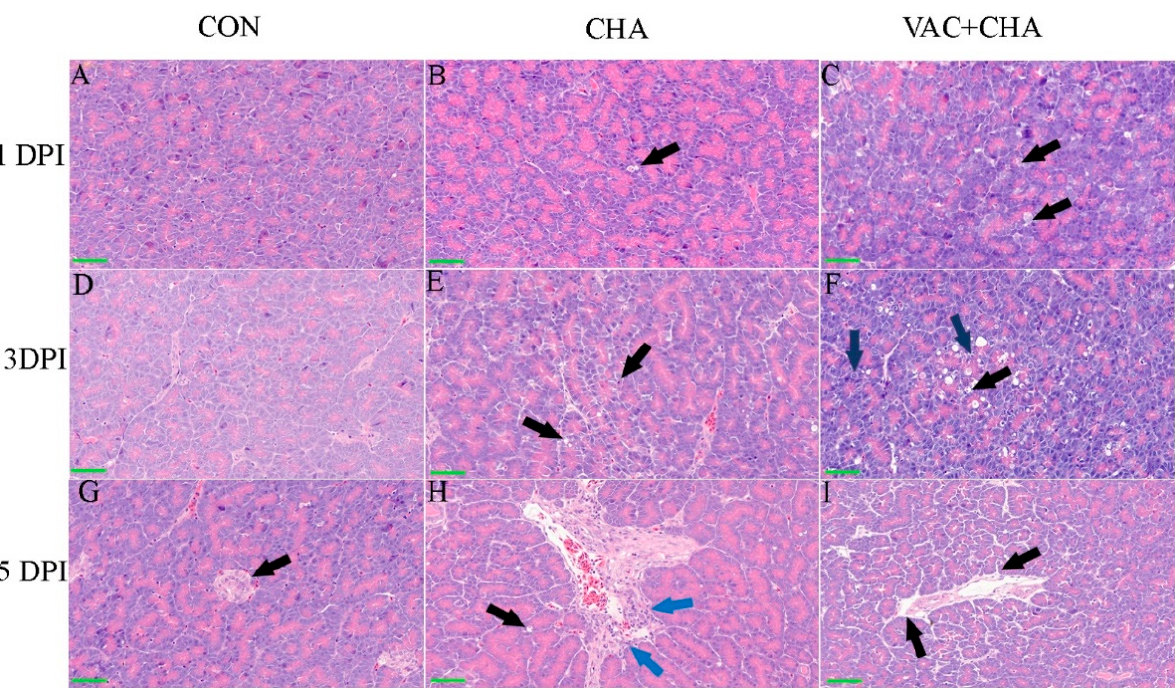
Figure 2. Histopathological changes induced by the Newcastle disease virus (ZJ1) in the pancreas of specific-pathogen-free (SPF) and vaccinated chicken. Panels ( A – C ), ( D – F ), and ( G – I ) show the histopathology of the control, NDV-infected (CHA), and vaccine + NDV (VAC + CHA)-infected groups at 1-, 3-, and 5-days post infection (DPI), respectively. Histopathological changes were not found from the control group. Severe histopathological changes were induced by the NDV infection in SPF chickens, including ( B ) single-cell, ( E ) cytoplasmic vacuolation, and single-cell necrosis (arrow) and ( H ) single-cell necrosis (black arrow) and perivascular lymphocytic infiltration (blue arrows). However, in vaccinated chickens, histopathological changes induced by the NDV challenge include ( C ) individualized shrunken cells. ( F ) The black arrow shows single-cell necrosis, and the blue arrow shows individualized and shrunken cells and ( I ) mild perivascular edema at 5 DPI. Panels in the control group do not show any pathological changes, and unaffected endocrine pancreatic cells from the control group ( G ) are marked with arrowheads.